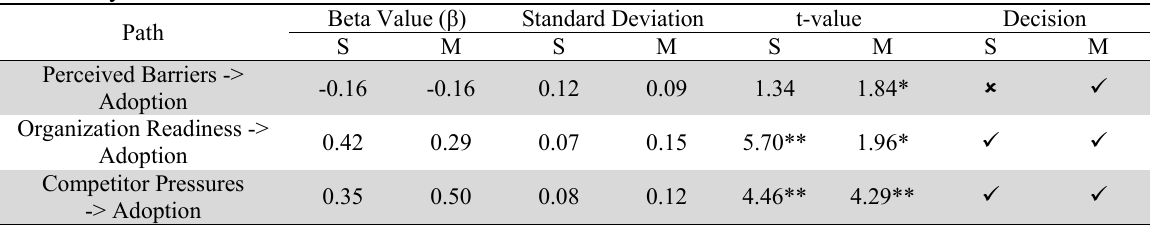
Path Analysis and T-Value Beta Value ( β ) Standard Path